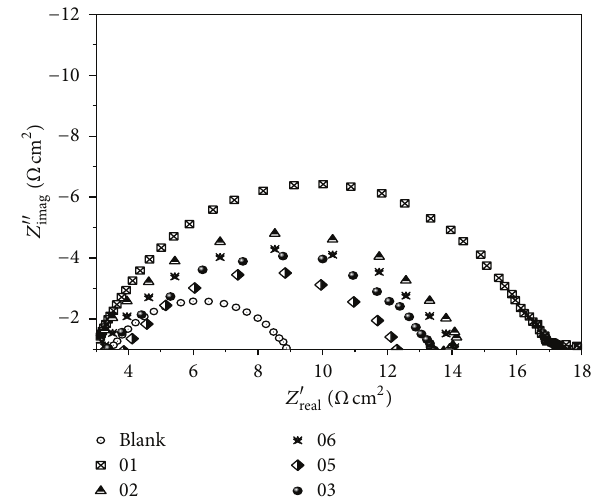
Figure 11: Nyquist plots of mild steel in 1N H 2 SO 4 in the absence and presence of optimum concentration of various inhibitors (01– 06).